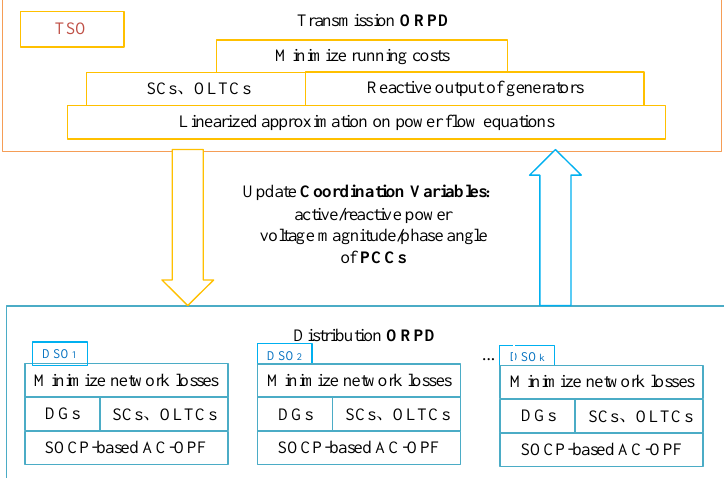
Figure 1. The framework of the proposed CTD-ORPD.